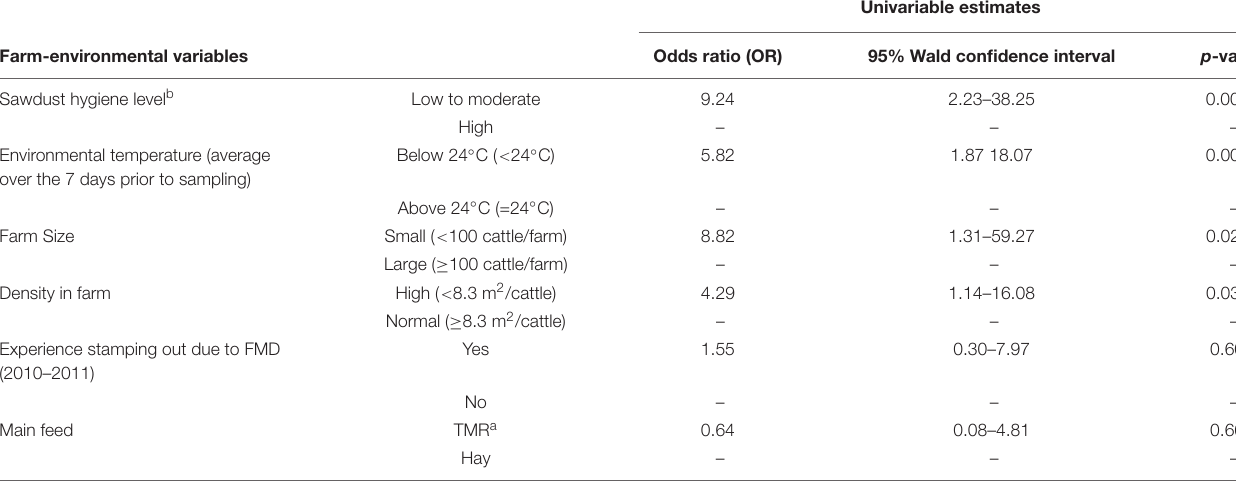
TABLE 1 | Farm-environmental variables associated with C. jejuni prevalence on dairy cattle farms using univariable generalized estimating equations (GEE) model.